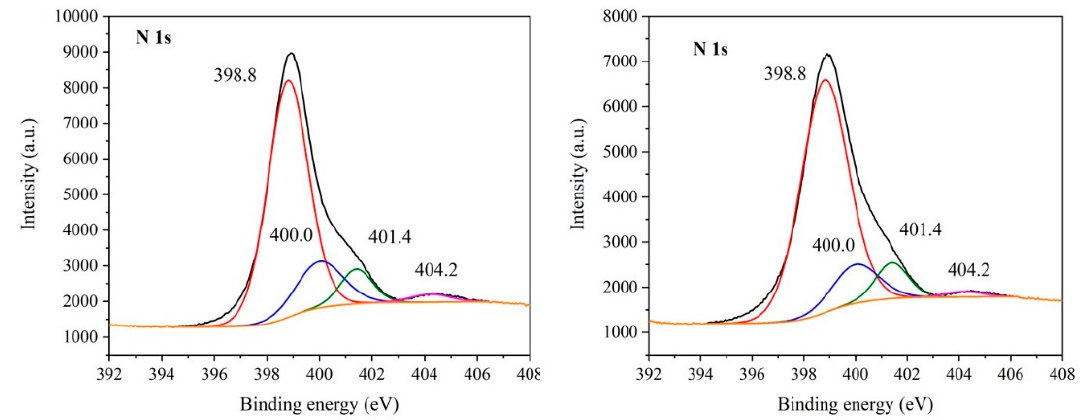
Figure 5. X-ray photoelectron spectrometry (XPS) spectra of N 1s of Ex3 ( left ) and Ex3 30 % H 2 O 2 nanomaterials ( right ).